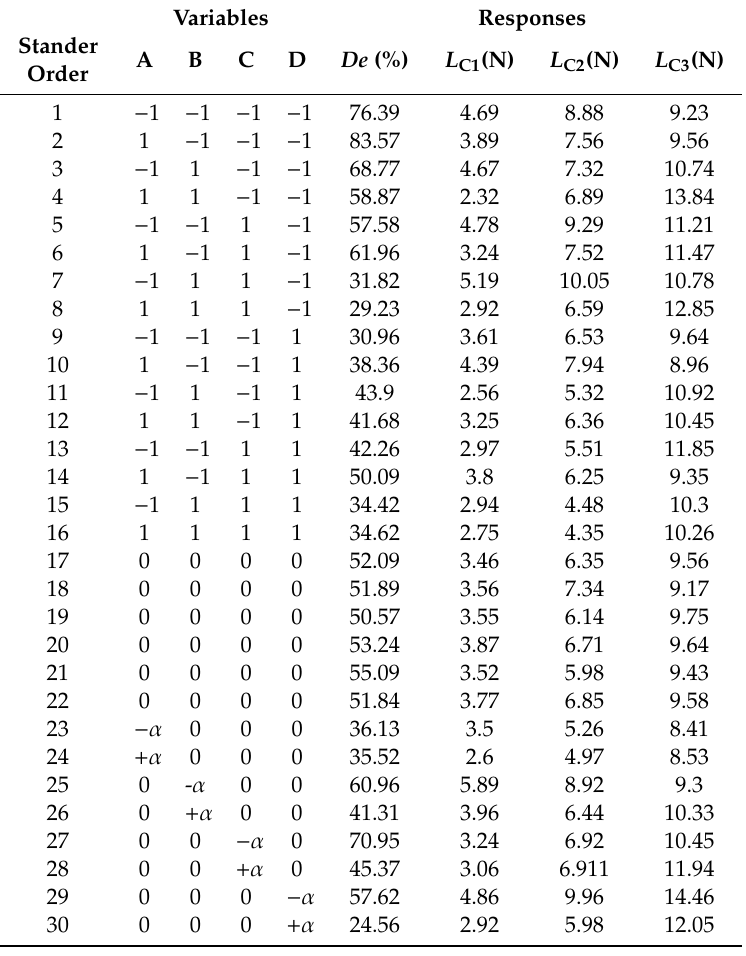
Table 2. Experimental conditions and actual values of di ff erent responses in CCD design.